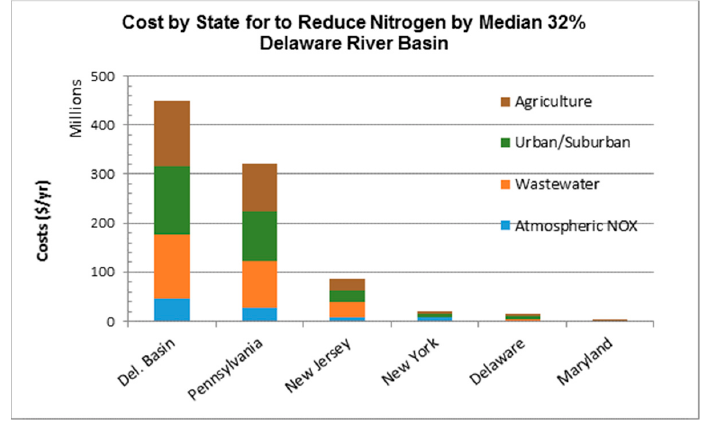
Figure 12. Least cost (in 2010 dollars) by state to reduce nitrogen loads by 32% in Delaware Basin.